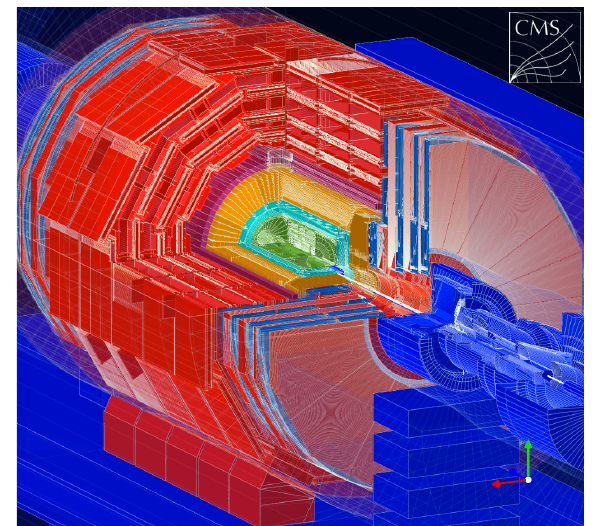
Figure 3. CMS detector model for 2021 built with